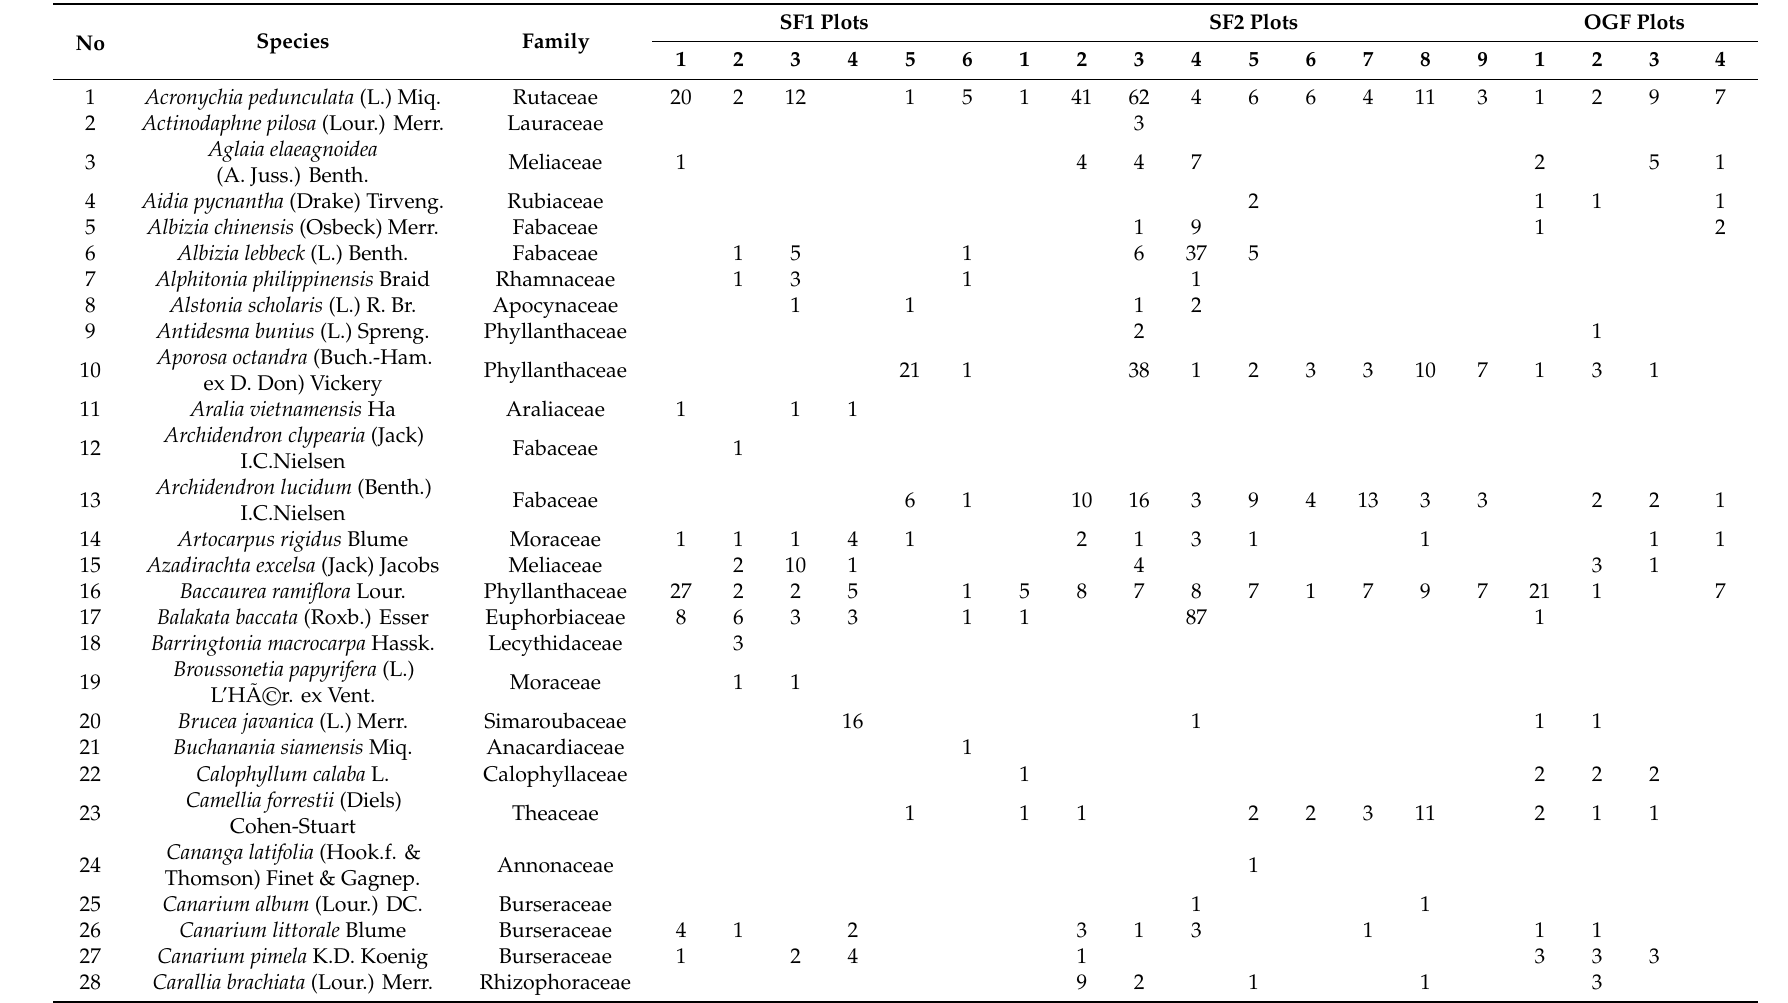
Table A2. Number of Species Individuals Per Study